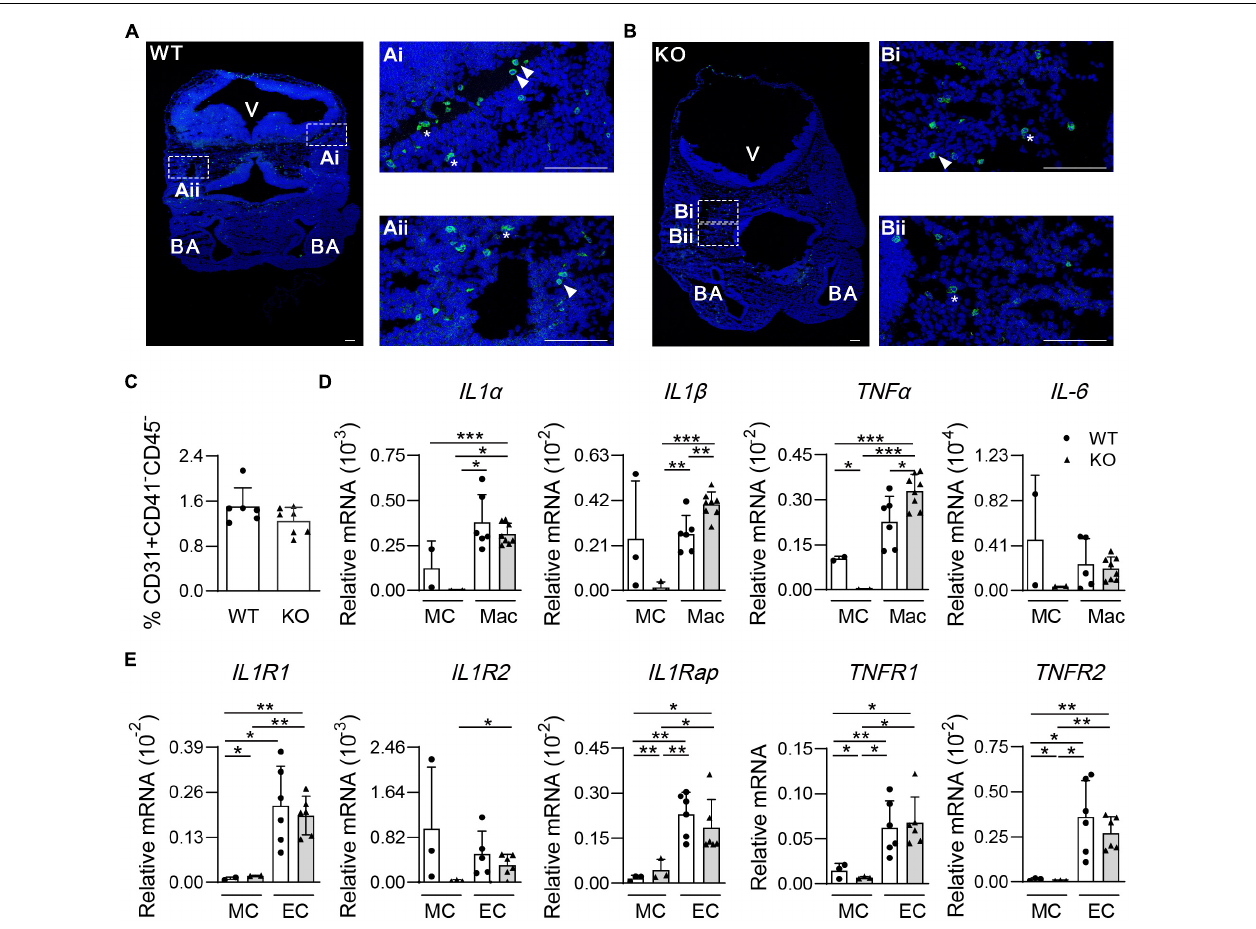
FIGURE 4 | The morphology of microglia and gene expression of pro-inflammatory pathways in the mouse embryonic head. (A,B) Representative confocal images of immunostaining by F4/80 (microglia) and Hoechst 33342 in the E11.5 head sections. Wild-type (WT) (A) 48 sp., knockout (KO) (B) 45 sp. Arrowhead indicated round microglia. Star indicated non-round microglia. V, ventricle; BA, branchial arches. Bar = 100 µ m. (C) The percentages of endothelial cells (CD31 + CD41 + CD45 − , ECs) in the E11.5 embryonic head. n = 4. (D) Relative mRNA expression of IL-1 α , IL-1 β , TNF- α , and IL-6 normalized to β -actin in the microglia (CD45 + F4/80 + CD11b + , Mac) and mesenchymal cells (CD31 − CD45 − CD41 − , MCs) of the E11.5 head by qRT-PCR. n ≥ 2; * p < 0.05, ** p < 0.01, *** p < 0.001. (E) Relative mRNA expressions of IL-1 and TNF receptor ( IL1R1 , IL1R2 , IL1Rap , TNFR1 , and TNFR2 ) in ECs (CD31 + CD41 − CD45 − ) and mesenchymal cells (CD31 − CD45 − CD41 − , MCs) of the E11.5 head were determined by qRT-PCR. n ≥ 2. * p < 0.05, ** p < 0.01, *** p <